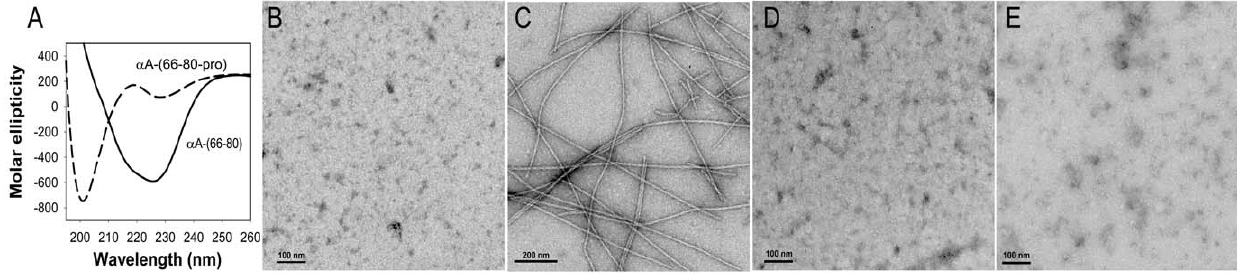
Figure 7. Amyloid-like characteristics of the a A-(66-80) peptide. (A) Far-UV CD spectra of 0.1 mg/ml a A-(66-80) peptide and the Pro- substituted peptide in phosphate buffer, pH 7.2, obtained as described under methods. Proline substitution abolishes the b -sheet structure of the peptide. (B, C, D) TEM micrographs of peptides incubated in 50 mM phosphate buffer (pH 7.2) at 37 u C. (B) a A-(66-80) at 0 min; (C) a A-(66-80) after 24 h; and (D) TEM of the Pro-substituted a A-(66-80) peptide after 24 h incubation. (E) TEM of the a A-(1-14) peptide after 24 h incubation. TEM studies show that a A-(66-80) peptide forms fibrils (D), whereas following Pro-substitution, the same peptide is unable to form fibrils (E), suggesting that a propensity to form b -sheet structure is necessary for fibril formation. The a A-(1-14) peptide did not form fibrils (E) and did not show b -sheet structure (data not shown).